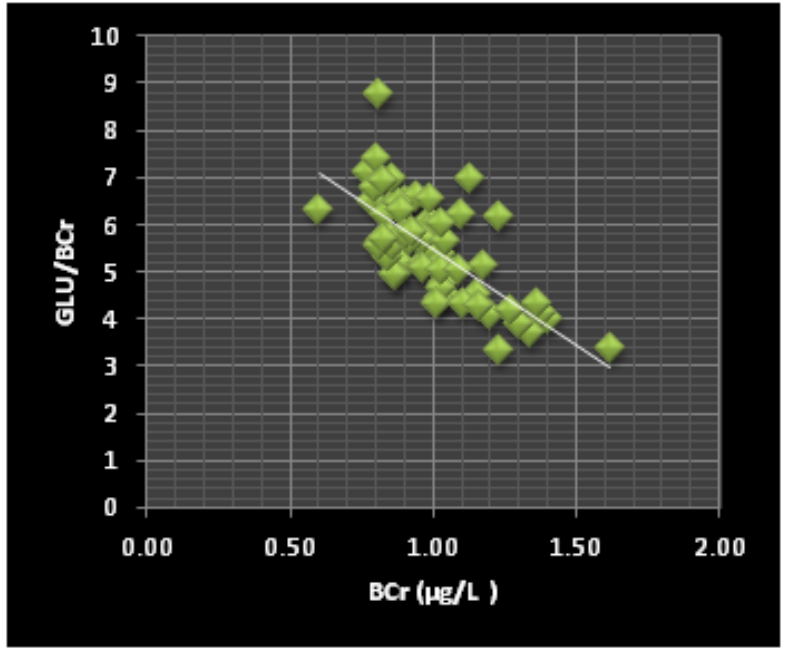
Figure 2. The correlation between the BCr levels and the Glu/BCr ratio in the ThPP workers (r = − 0.70, p < 0.0001). (r = − 0.70, p <